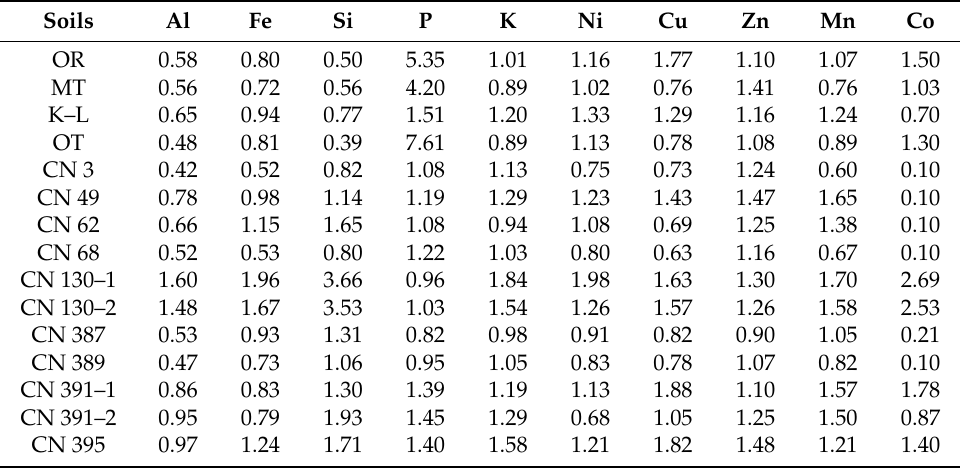
Table 3. The accumulation of the trace elements according to the ratio of concentrations in soil and parent rock